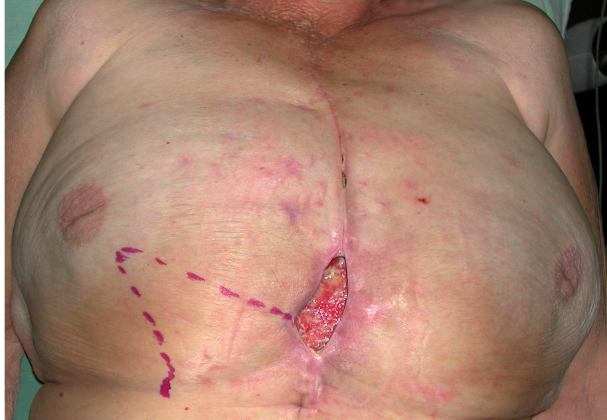
Fig. 3 - Female patient, 65 years of age with post-CABG dehiscence in the 42 th postoperative day, treated with patch composed of mammary tissue and right lower pedicle.